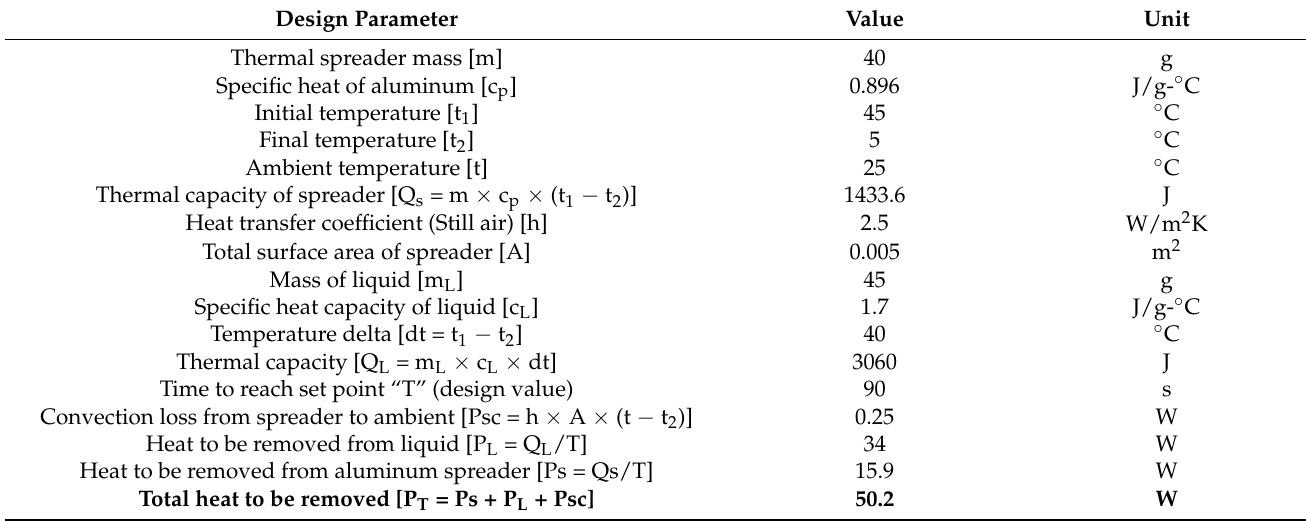
Table 1. Design parameters for selection cooling